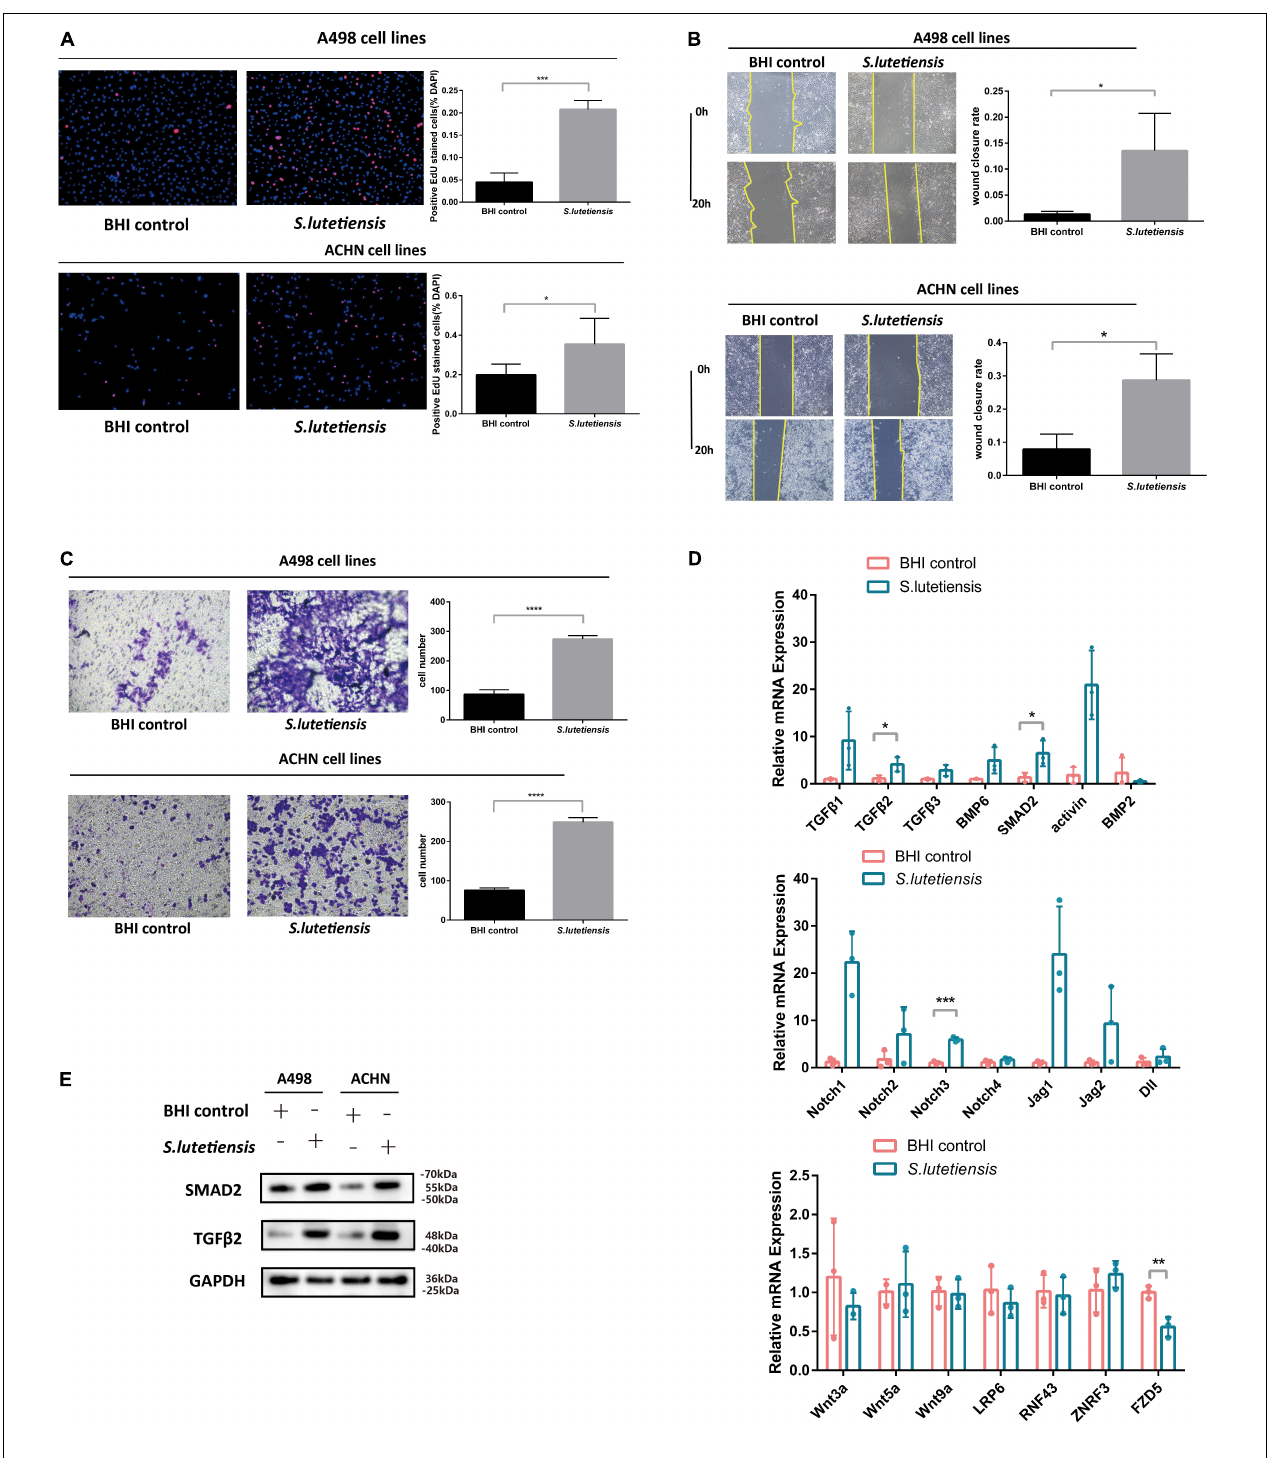
FIGURE 4 | Streptococcus lutetiensis conditioned medium (Sl.CM) promotes A498 and ACHN cell proliferation, migration, and invasion through the TGF- β signaling pathway. (A) EdU assay showed that Sl.CM increased A498 and ACHN cell proliferation. (B) Wound healing assay showed that Sl.CM increased A498 and ACHN cell migration. (C) Transwell invasion assay showed that Sl.CM increased A498 and ACHN cell invasion. (D) qRT-PCR showed that mRNA expression of TGF- β 2 and SMAD2 in TGF- β signaling pathway was increased in Sl.CM treated ACHN cells but mRNA expression of Wnt and Notch signaling pathway showed no obvious difference between the two groups. (E) Western blot showed that TGF- β 2 and SMAD2 protein expression were increased in Sl.CM treated A498 and ACHN cells. Results are presented as the mean ± SD and statistical significance was determined using the unpaired t -test. * p < 0.05, ** p < 0.01, *** p < 0.001, **** p < 0.0001. Sl.CM, S. lutetiensis conditioning medium; EdU, 5-ethynyl-2 (cid:48) -deoxyuridine; SD, standard deviation.